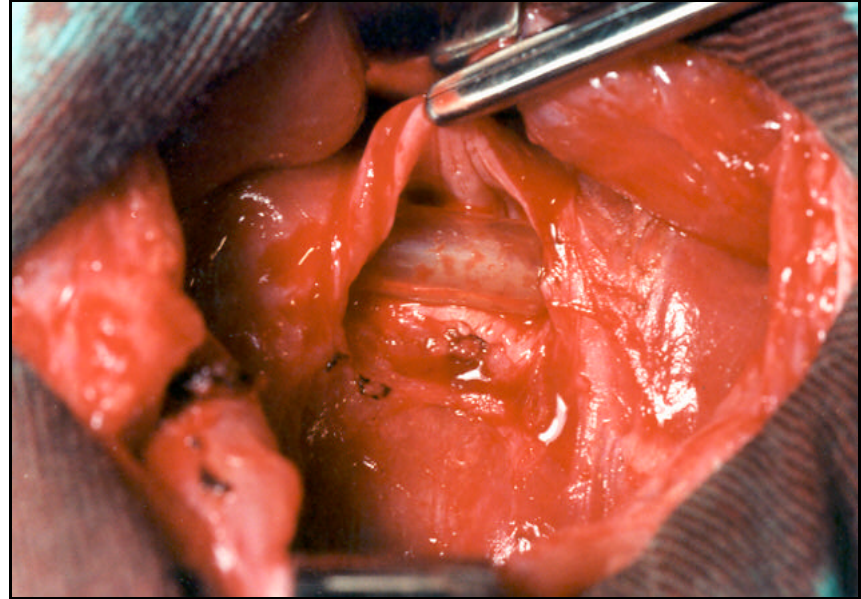
FIGURA 1 - Extensa ressecção de tecido